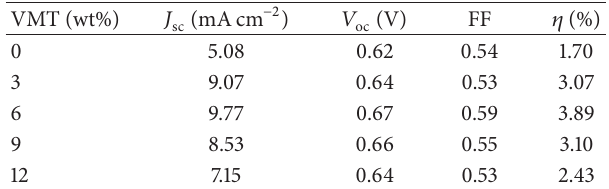
Table 2: The photovoltaic parameters of the DSSCs with various contents of